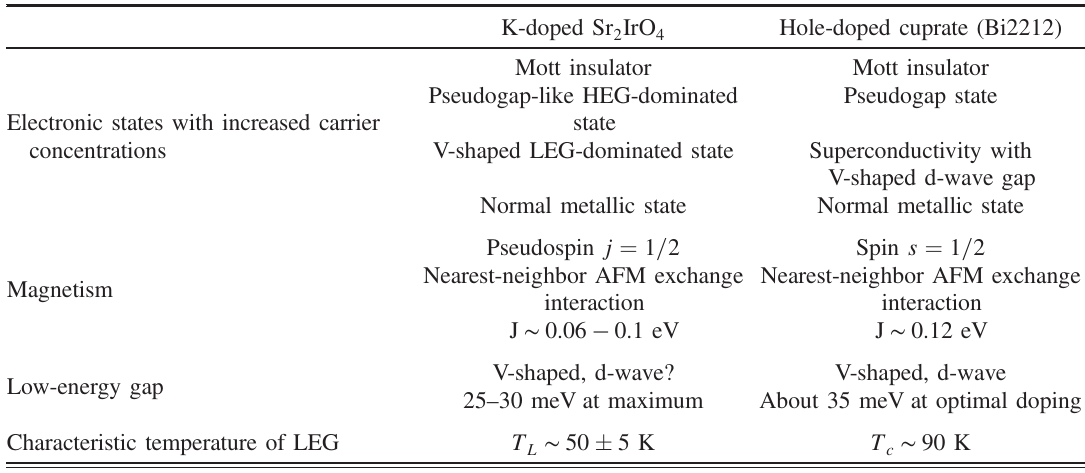
TABLE I. Comparison of K-dosed Sr 2 IrO 4 and hole-doped